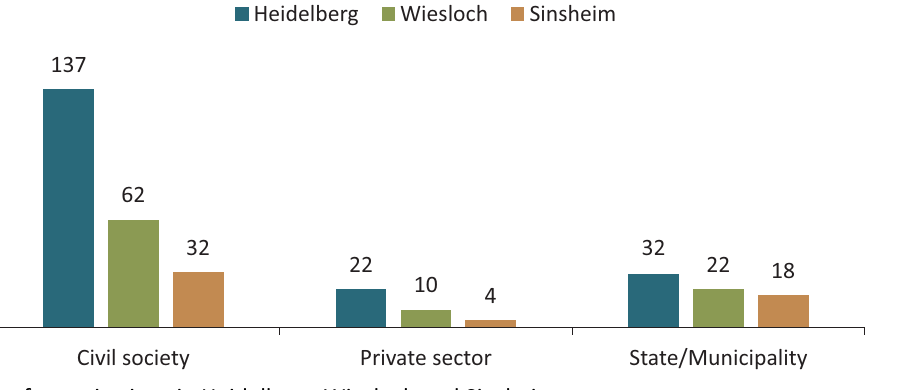
Figure 1. Numbers of organizations in Heidelberg, Wiesloch and